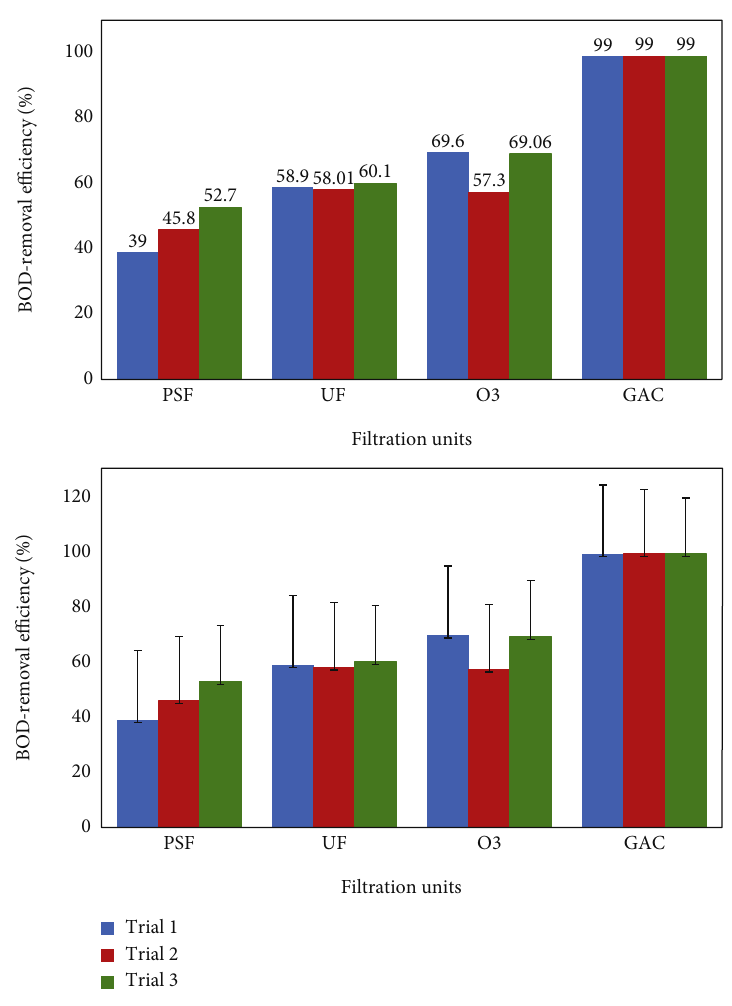
Figure 7: Bar chart representing the removal e ffi ciency of pollutants in PSF, UF, O